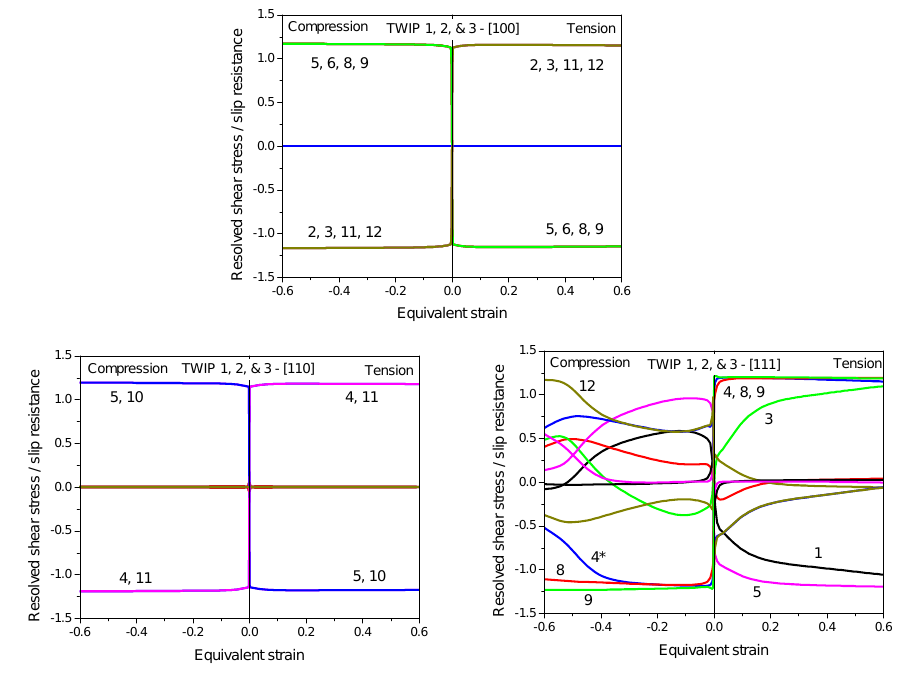
Figure 6. Activity of slip planes in single crystal of TWIP 1, TWIP 2, and TWIP 3 steels under tension and compression in three crystallographic directions.